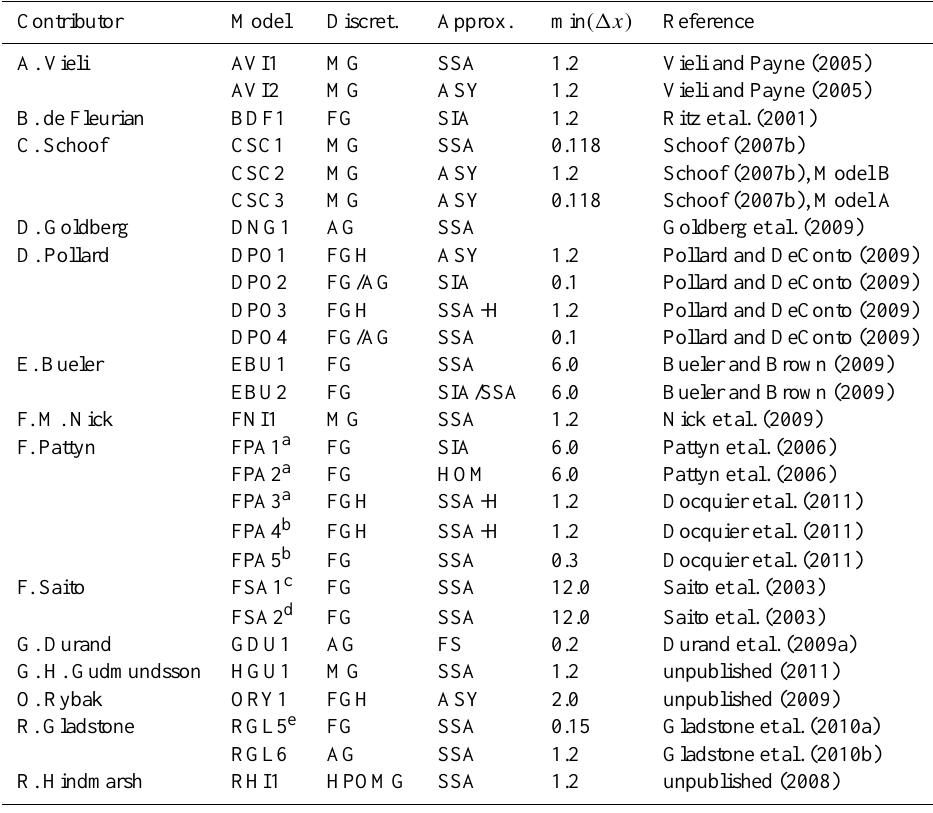
Table 2. List of participating models. FG = Fixed grid model, FGH = FG model with use of Pollard and DeConto heuristic (which is equivalent to the asymptotic model B ∗ of Appendix A3 when used with a shallow ice model for flux, as in model DPO1), MG = moving grid model, AG = adaptive grid model, HPOMG = MG using high polynomial-order finite difference stencils, SIA = Shallow Ice Approximation without explicit model of grounding line migration (i.e., no flux condition at the grounding line), SSA = Shallow-Shelf Approximation, SSA-H = Shallow-Shelf Approximation with heuristic Eq. (14) at the grounding line, HOM = Higher-Order Model, FS = full-Stokes model. The asymptotic models ASY are described in Appendix A3. These are SIA models that include a systematic parameterization of grounding line migration based on near-grounding line boundary layer in which the shallow ice approximation fails. An SIA/SSA model in which the SSA is used to compute basal sliding rates, and a SIA correction is applied to compute flux due to vertical shearing (Bueler and Brown,